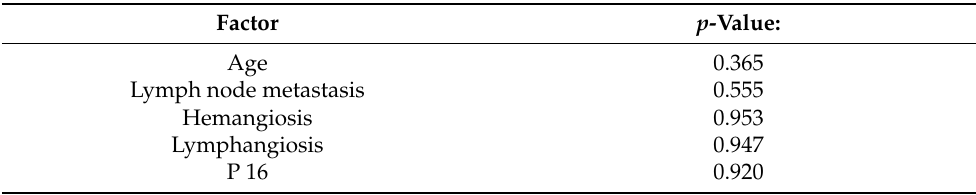
Table 3. Multivariate analysis of the prognostic impact of age, lymph node metastases, hemangiosis, lymphangiosis and p16+ staining.